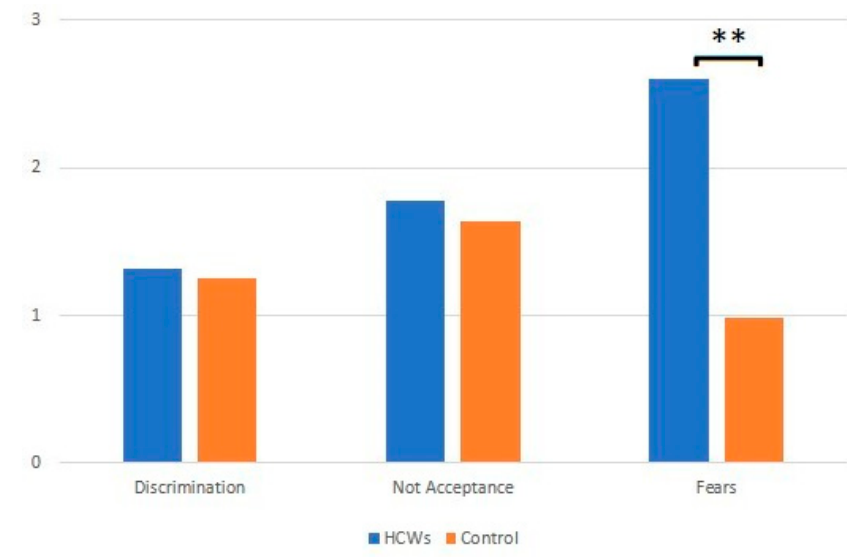
Figure 1. Results of SSPCS questionnaire (significance: ** p < 0.01).